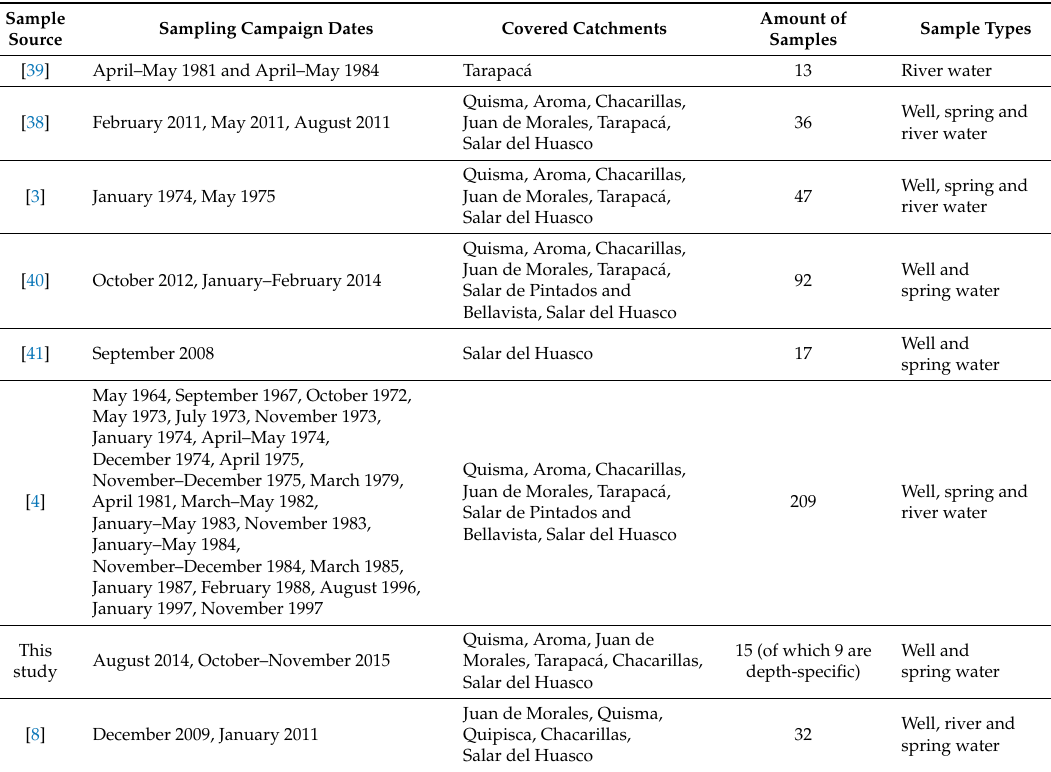
Table 1. Summary of stable isotope data of groundwater, spring- and river water in the study region from different reports and studies